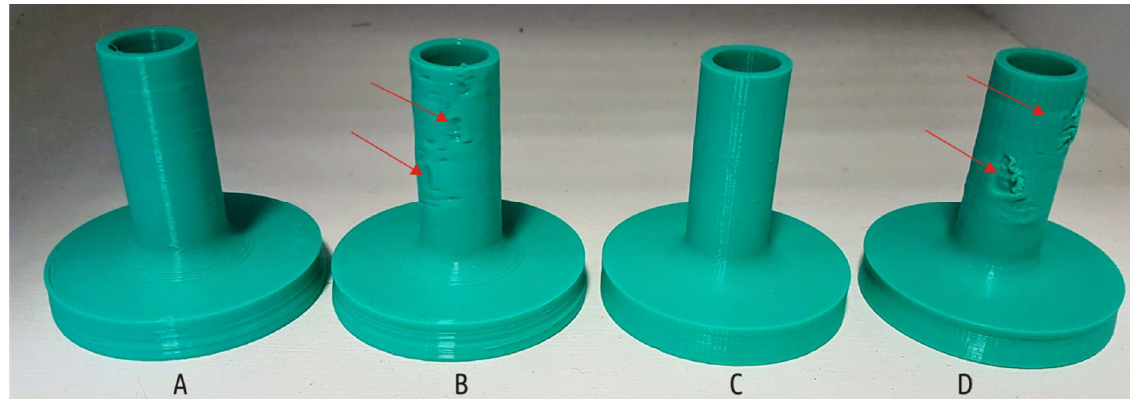
Figure 8. The appearance of the Shape 5 samples printed on the modes A, B, C, and D; red arrows indicate serious defects.